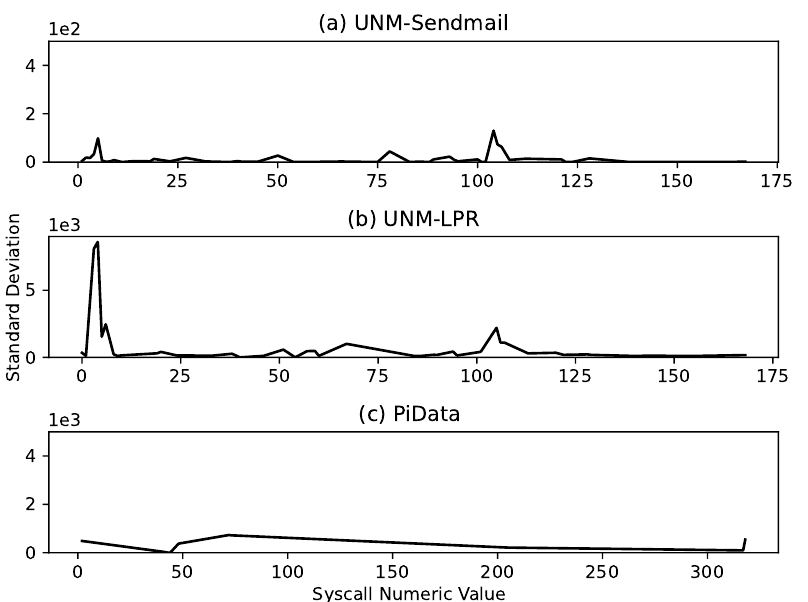
Figure 7. Dataset consistency analysis: Variation in frequency of syscalls of: ( a ) UNM Sendmail, ( b ) UNM-LPR, and ( c ) PiData datasets observed in 10 equal-sized segments. The plot shows the standard deviation in frequencies of three datasets’ syscalls. It can be seen that the frequencies of syscalls in the UNM Sendmail dataset do not vary much in different segments of the dataset, while syscalls in the UNM-LPR dataset show varied syscall frequencies.